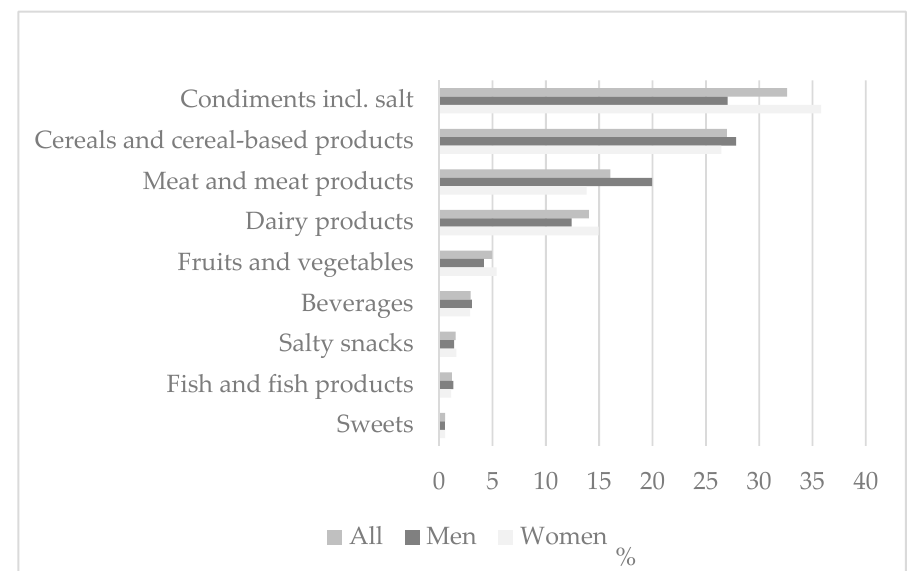
Figure 1. Contribution of different food groups to total dietary salt intake, all participants and by gender.